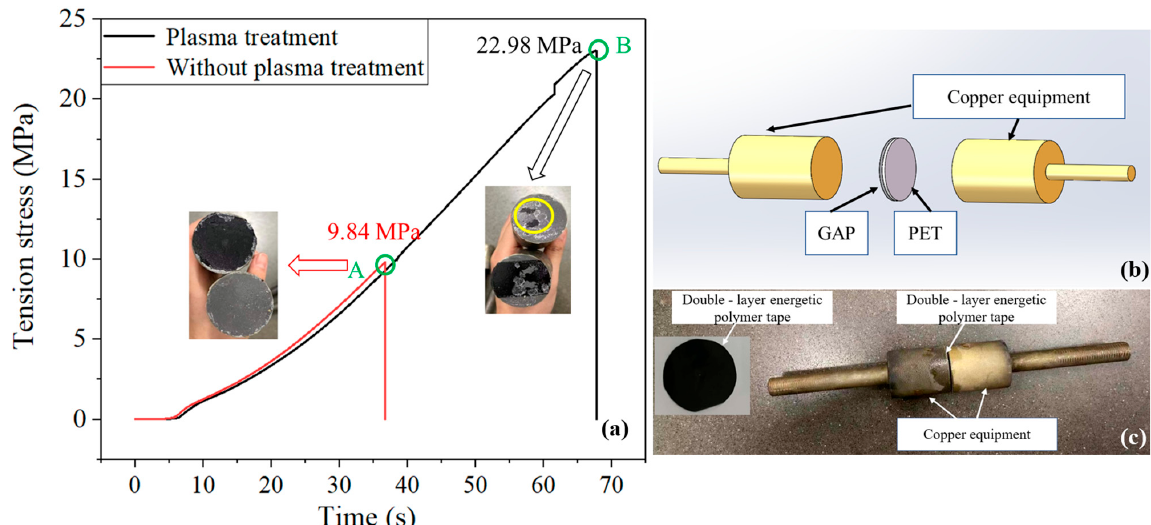
Figure 4. ( a ) Test results of tensile stress. The adhesion between PET and GAP pre- and post-plasma treatment was represented by a red line and black line, respectively. The tensile stress at point A is about 9.84 MPa, and the result of the double-layer band after it was pulled was shown as the arrow at point A. The tensile stress at point B was about 22.98 MPa, and the result of the double-layer band after it was pulled was shown as the arrow at point B. ( b ) 3D schematic diagram of tensile specimen. ( c ) Drawing of tensile specimen.